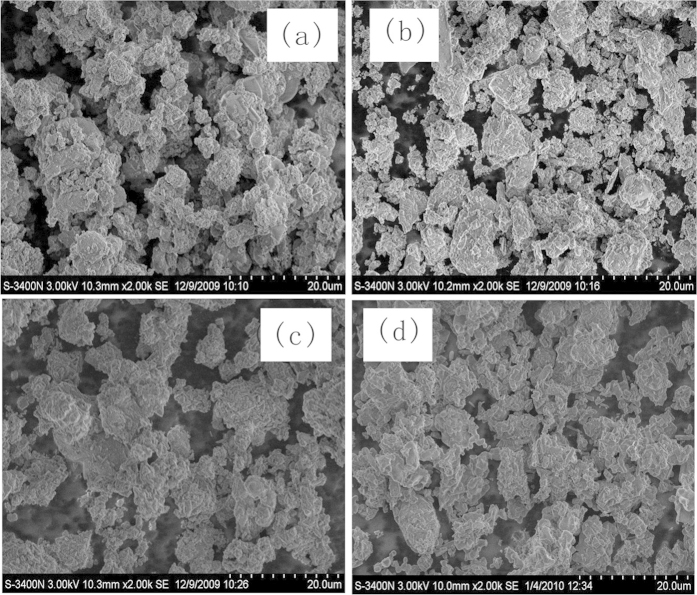
SEM photograph of fly ash after incineration at (a) 800 °C (b) 900 °C (c) 1000 °C (d) 1100 °C for 1.5 hours.